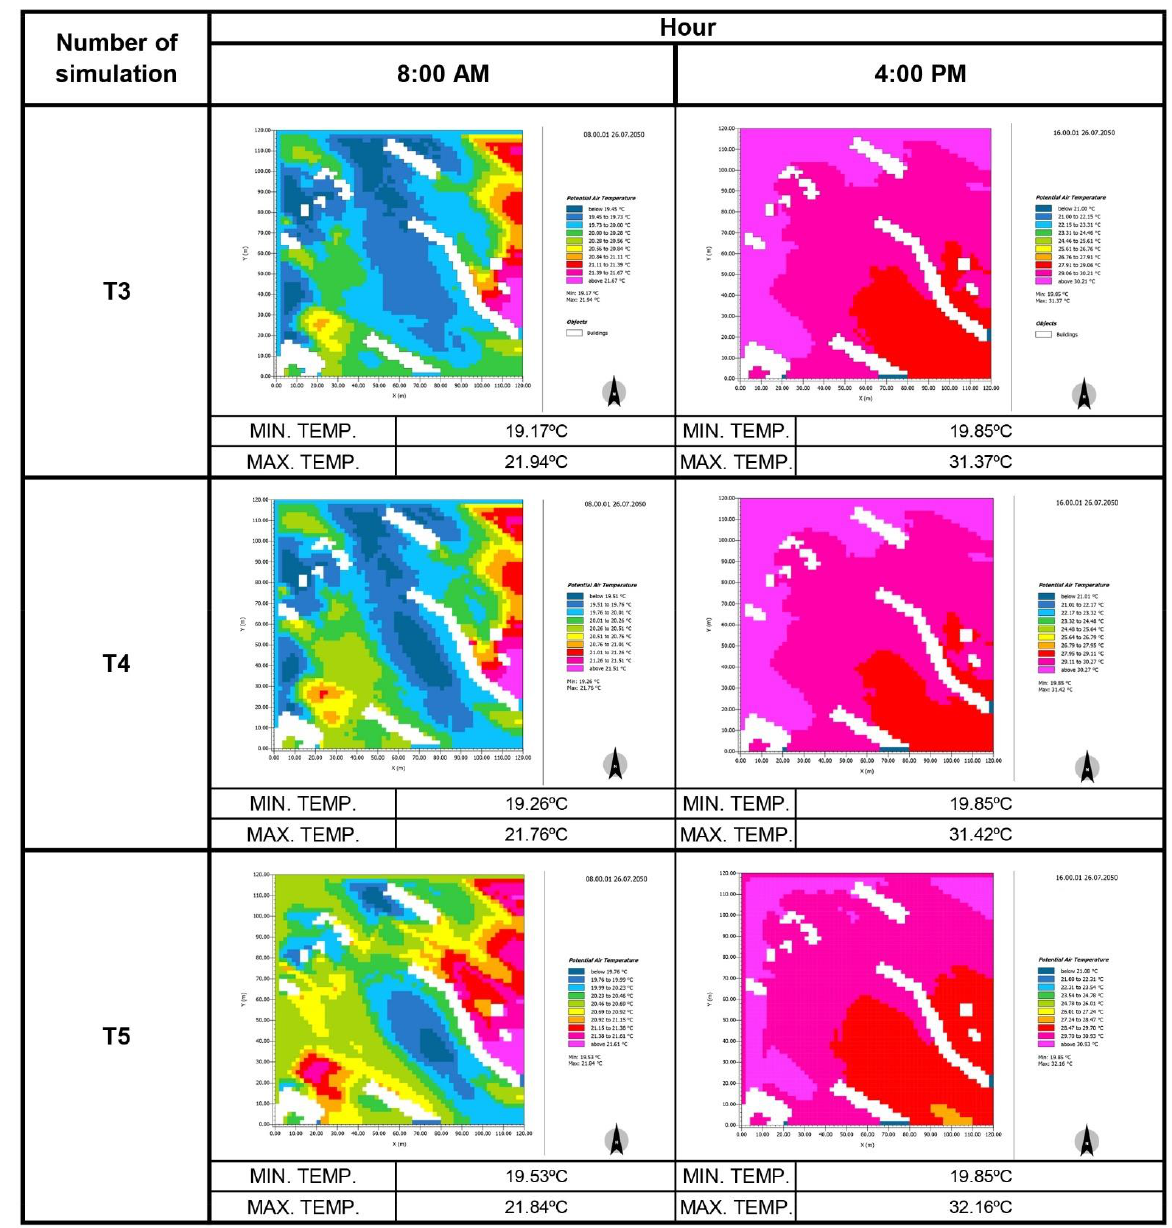
Figure 10. Comparison of T3 simulations with T4 and